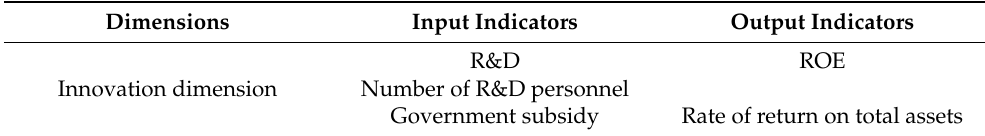
Table 2. Innovation dimension evaluation index system.